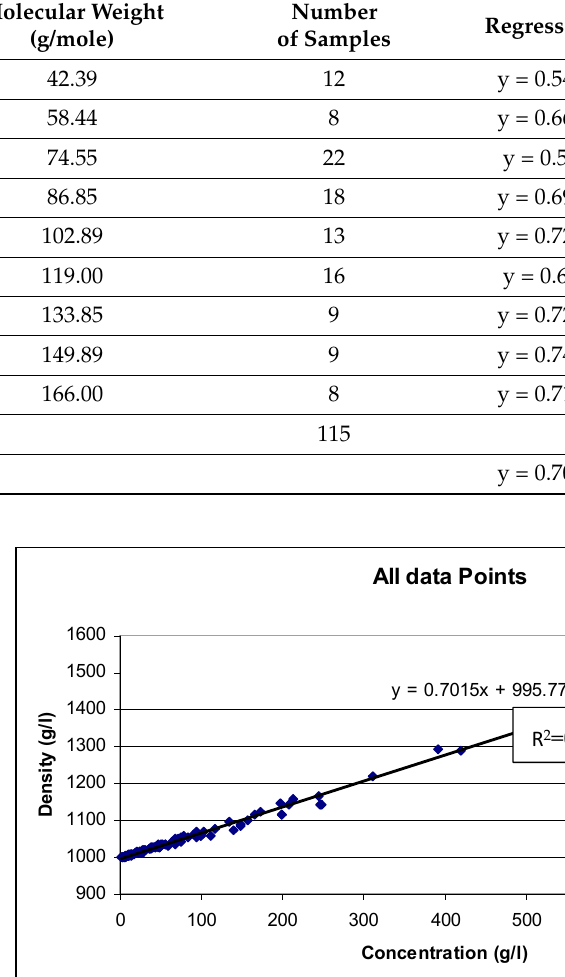
Table 1. Regression analyses of Baxter’s data [3].